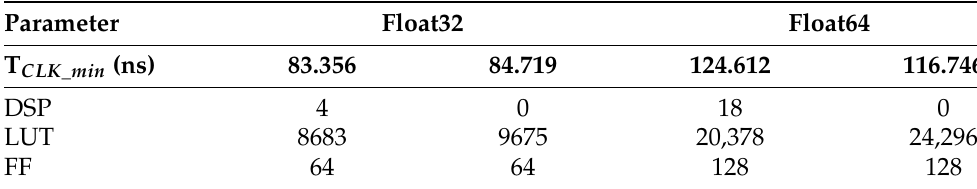
Table 3. Hardware needs in terms of speed (T CLK _ min ) and area (LUTs and FFs) with and wihtout DSPs, when floating-point NF is considered with different WLs and default rounding modes in